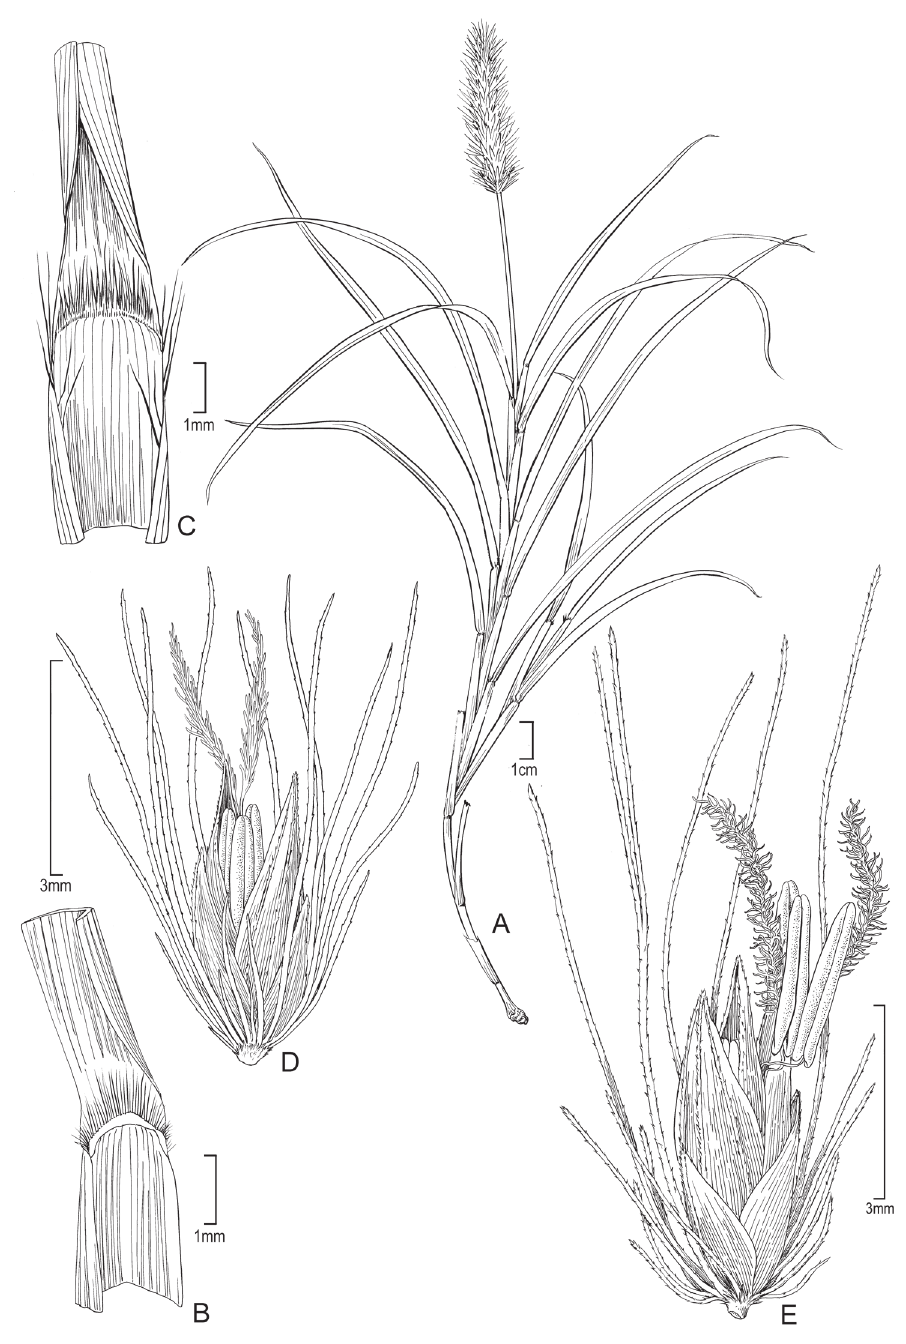
Figure 1. Cenchrus articularis (Trin.) M. Tornabene & W.L. Wagner A Habit, Perlman 10069 (US) B Ligule, Wood 10133 (US) C Ligule, Florence 9421 (US) D Spikelet with one floret, Wood 10112 (US) E Spikelet with two florets, Wood 10112 (US). Illustration by Alice